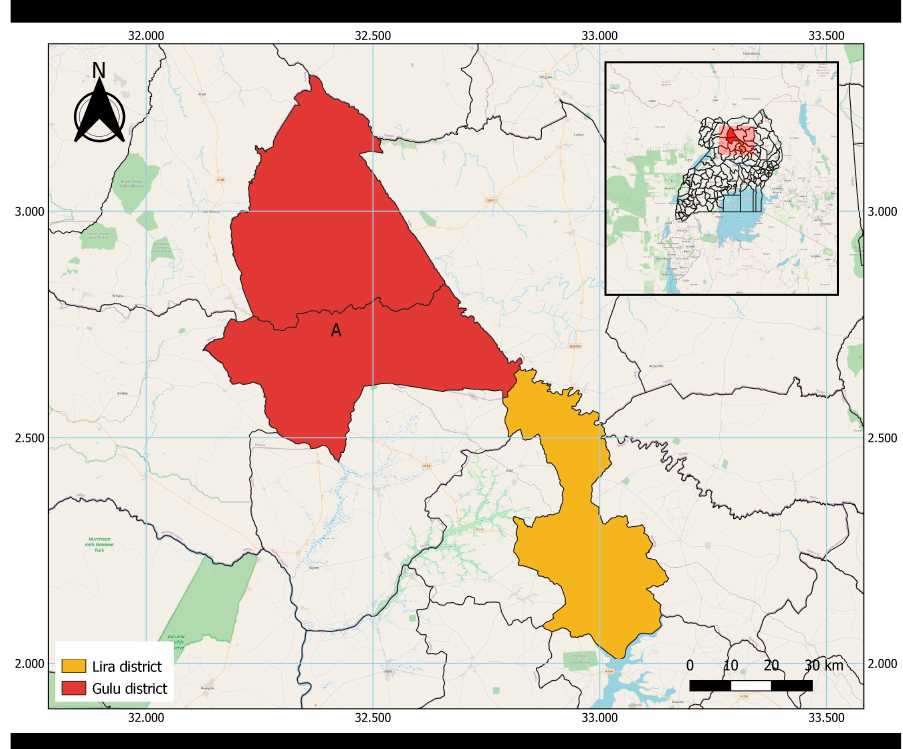
Figure 2 . A map showing the study areas . Figure 2. A map showing the study areas. A is the present-day Omoro district, which was a part of A is the present-day Omoro district, which was a part of the Gulu district at the study time. the Gulu district at the study